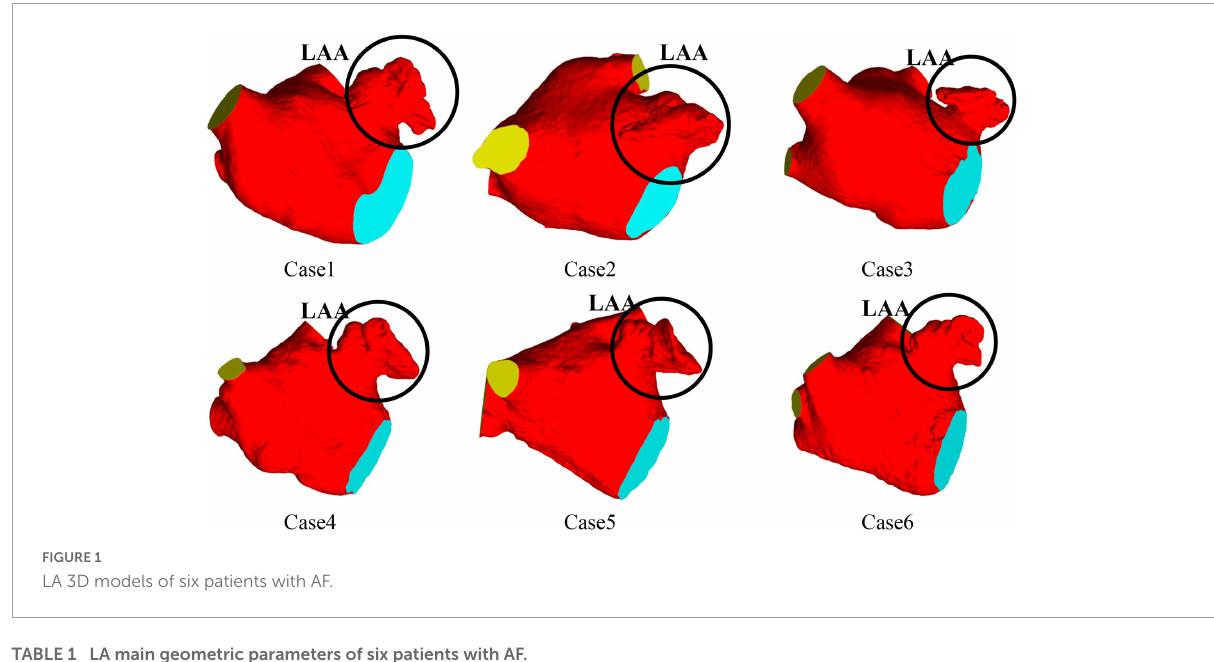
TABLE 1 LA main geometric parameters of six patients with